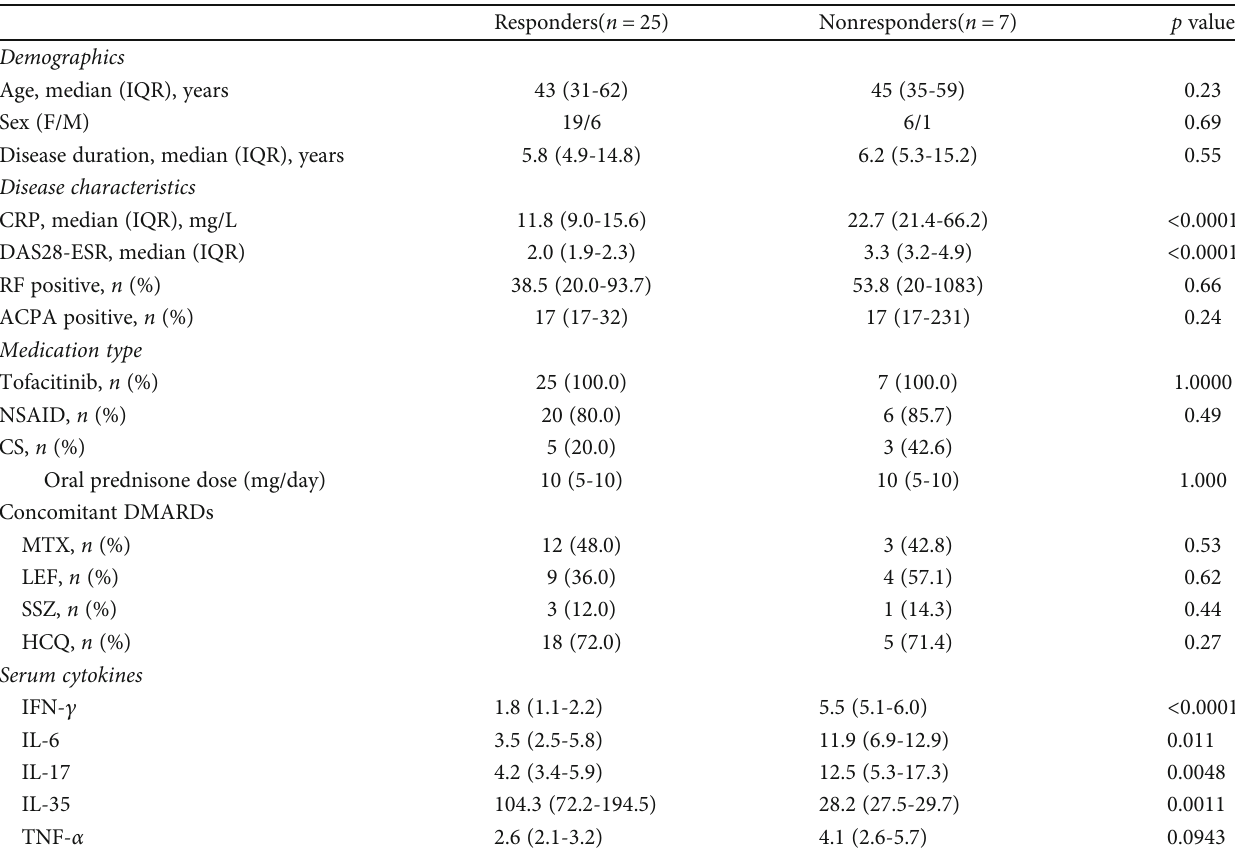
Table 3: Comparison of responders and nonresponders at week 24 after tofacitinib